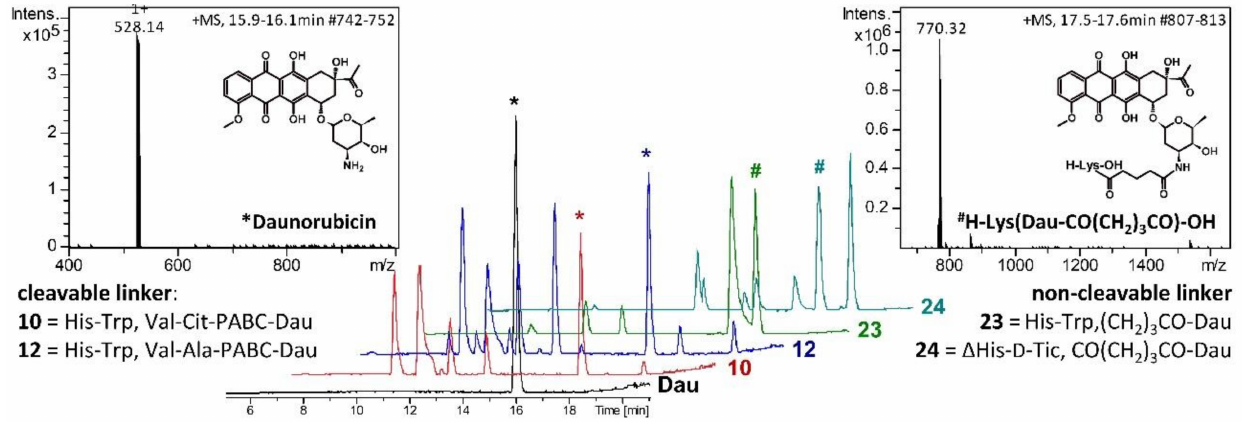
Figure 1. Degradation of the GnRH-III conjugates in presence of lysosomal rat liver homogenate. LC chromatograms of 10 , 12 , 23 , 24 and free Dau (control) after 24 h degradation and MS spectra of the released * daunorubicin (left) and non-cleavable metabolite, # H-Lys(Dau-CO(CH2)3CO)-OH